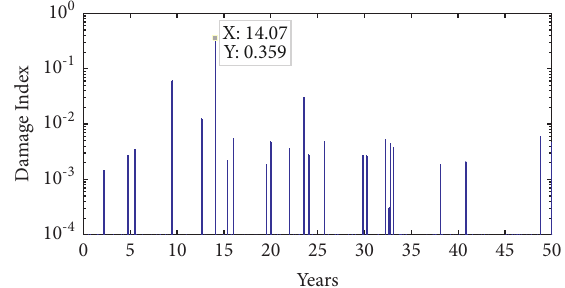
Figure 15: Damage index scenario for the service life of the 12- story